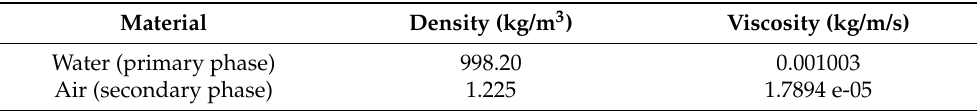
Table 1. Material properties employed in the CFD